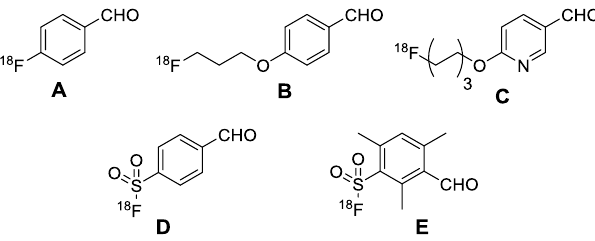
Figure 1. 18 F-Labeled aldehydes for peptide conjugation. ( A ) 4-[ 18 F]fluorobenzaldehyde (4-[ 18 F]FBA); 18 F-Labeled aldehydes for peptide ( B ) 4-{3-([ 18 F]fluoro)propoxy}benzaldehyde; ( C ) 6-{2-([ 18 F]fluoro)ethoxy}nicotinaldehyde; ( D ) 4- formylbenzenesulfonyl [ 18 F]fluoride; ( E ) 3-formyl-2,4,6-trimethylbenzenesulfonyl [ 18 F]fluoride .